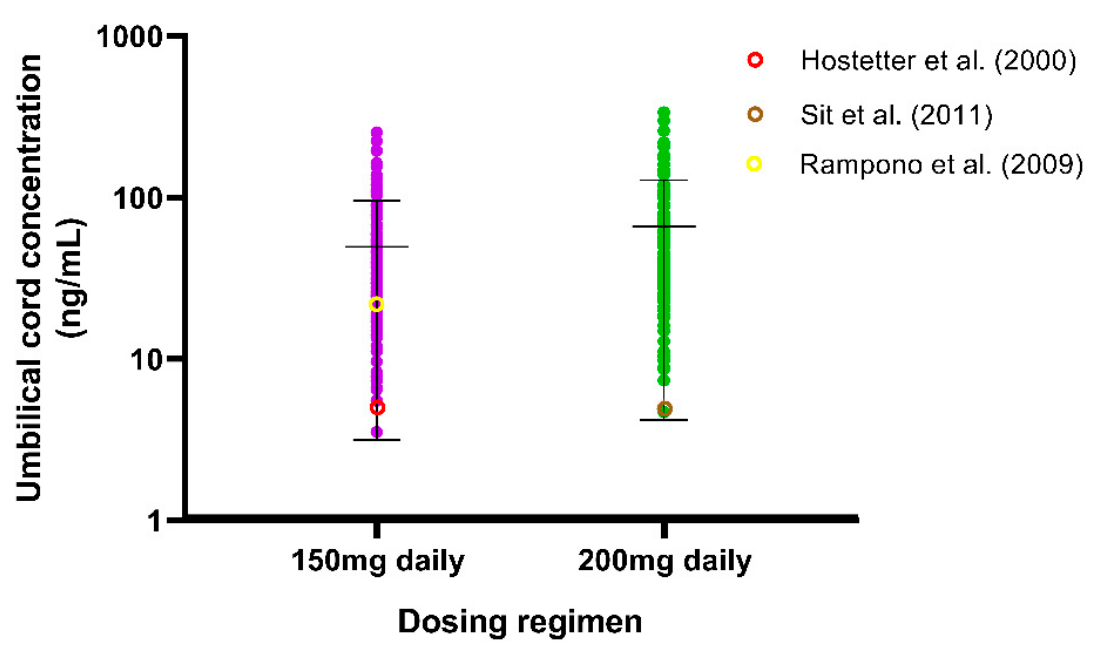
Figure 9. Simulated fluvoxamine foetal (umbilical cord) concentrations. Doses were administered to steady-state with sampling on the final 30-h period of GW 40. Solid circles represent individual predicted cord concentrations. Coloured open circles represent the observed umbilical cord concen- trations from Hostetter et al. [56], Sit et al. [57] and Rampono et al. [58],. Horizontal lines on the coloured data points represent the mean and SD.